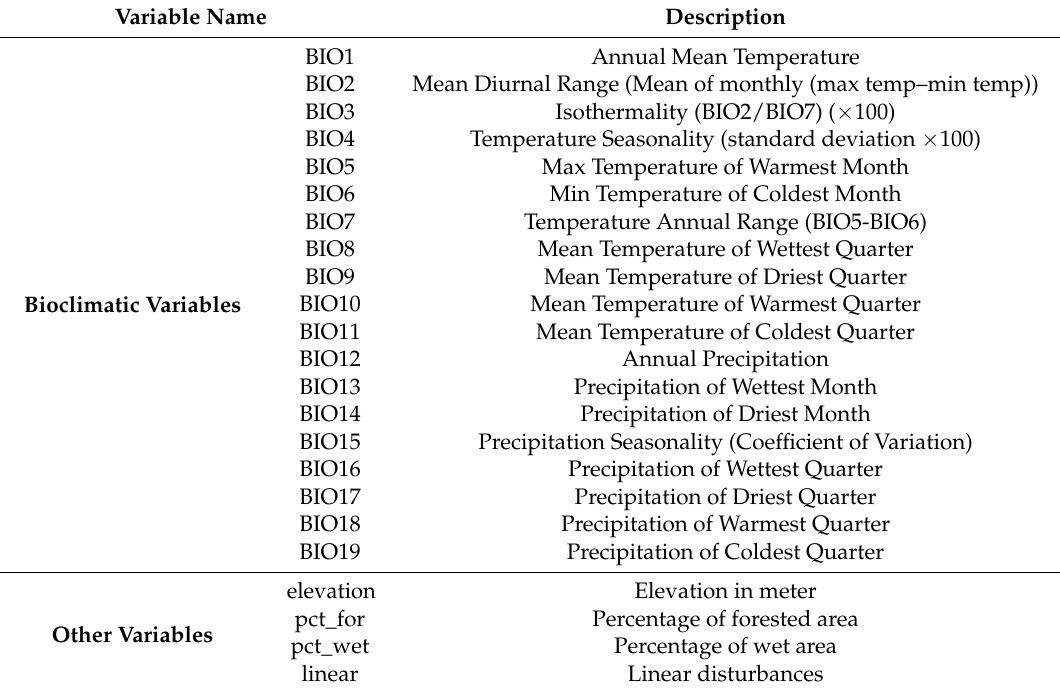
Table 1. List of explanatory variables used in the multivariate analysis with their description and the labels used for the purpose of the